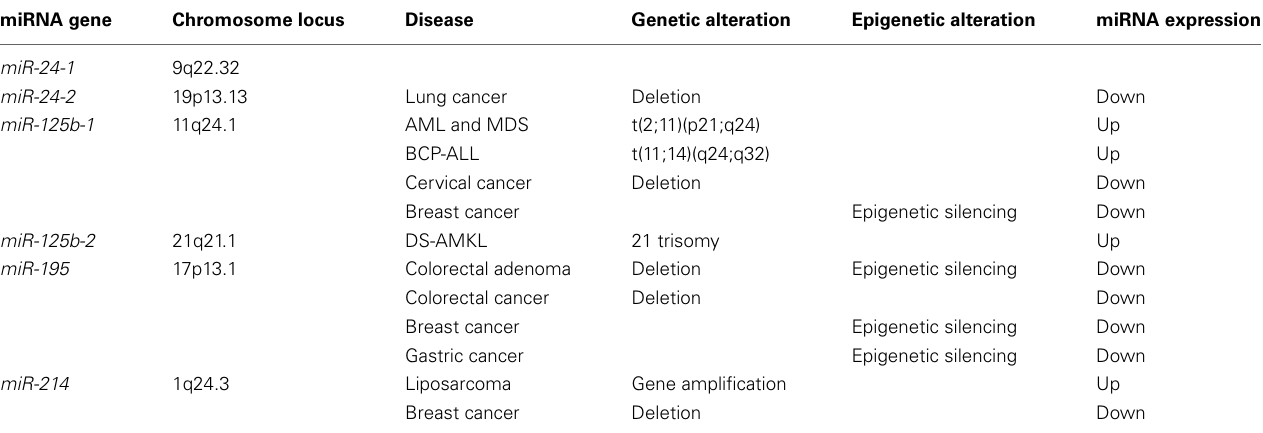
Table 2 | Genetic and epigenetic alterations of miR-24 , miR-125b , miR-195, and miR-214 . miRNA gene Chromosome locus Disease Genetic